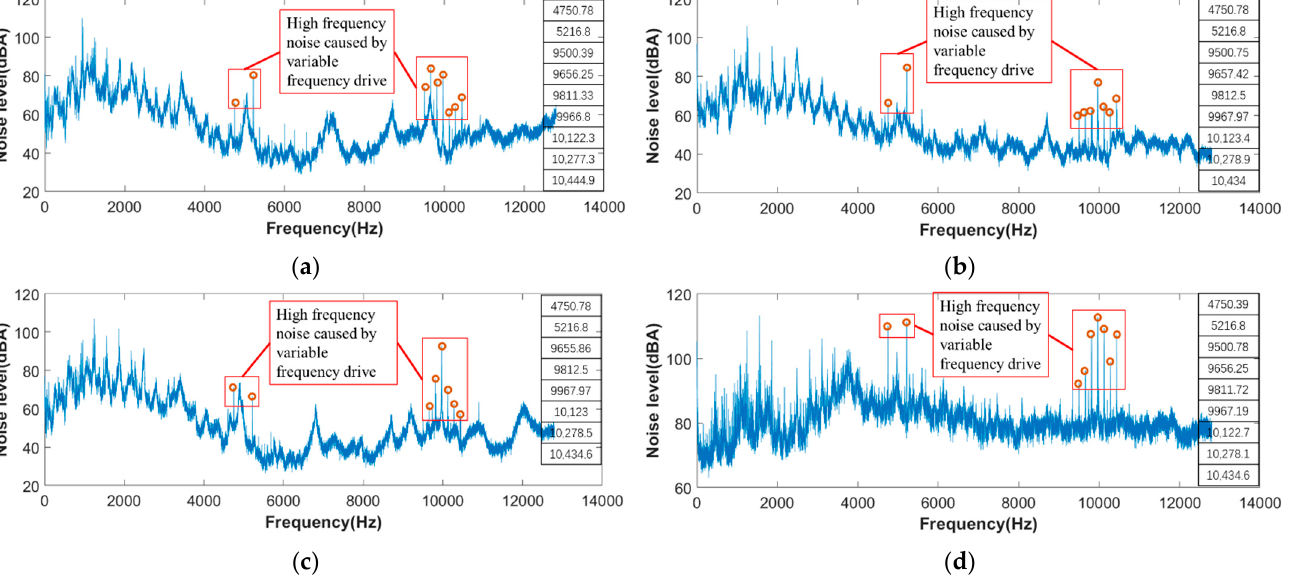
Figure 9. Spectrum diagram of noise level: ( a ) near the exhaust port, ( b ) near the middle of the motor side, ( c ) near the suction port and ( d ) near the suction flange.